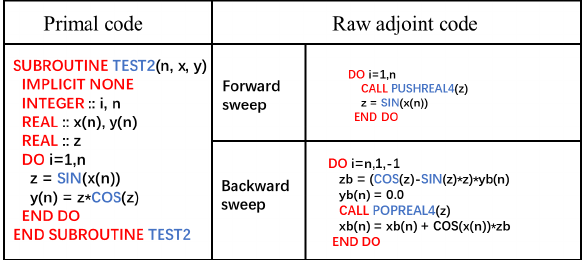
Figure 2. Case 2: the primal code and the raw adjoint